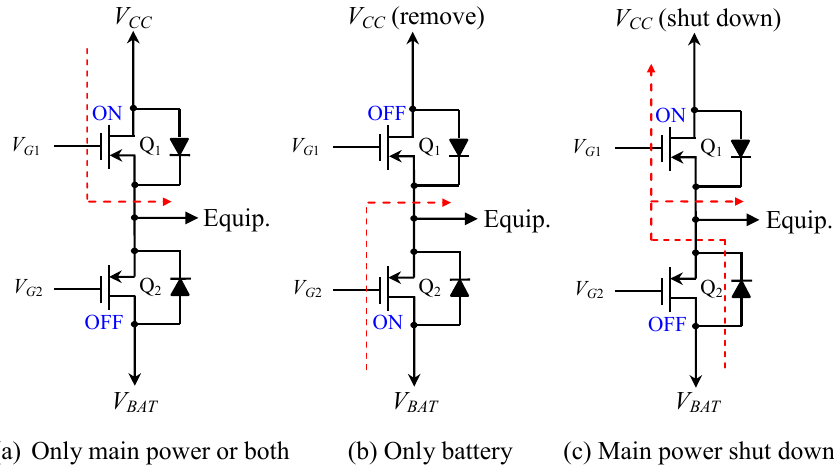
Figure 4. Power supply paths under different operating conditions.